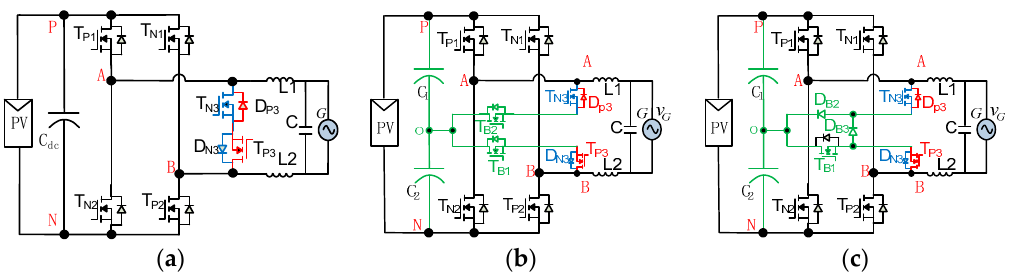
Figure 15. Direct Connection NPC topologies R1S2 under M = 2, N = 2. ( a ) HERIC topology R2; ( b ) R2S2-1 from R2; ( c ) R2S2-2 from R2 (new).